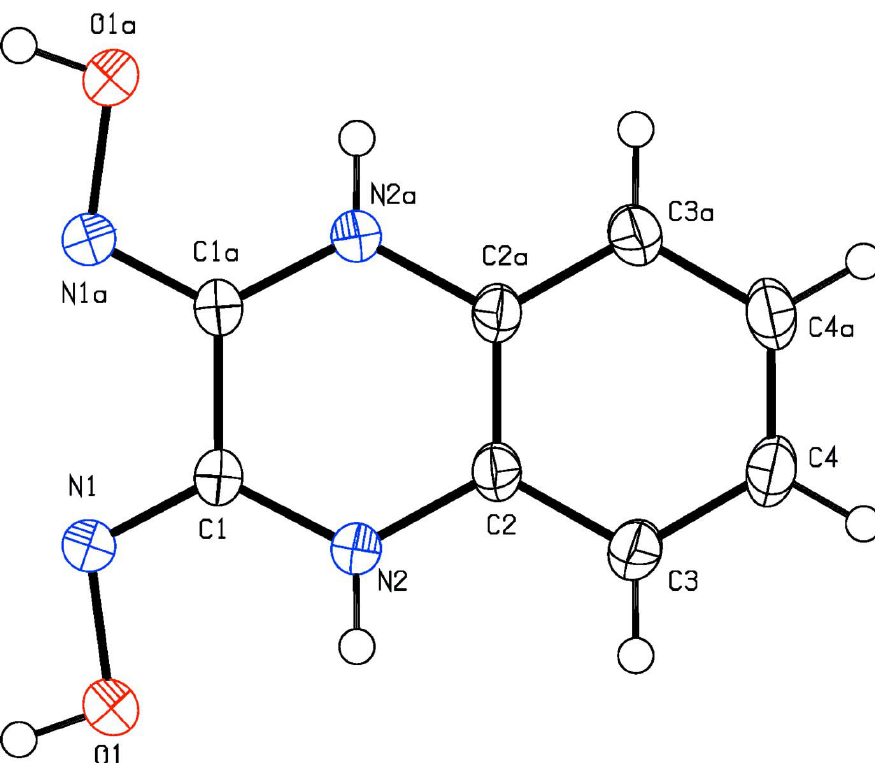
Figure 1 The molecular structure of the title molecule, with the atom-numbering scheme. Displacement ellipsoids are drawn at the 50% probability level [symmetry code: (a) 5/4 - x, 1/4 - y,